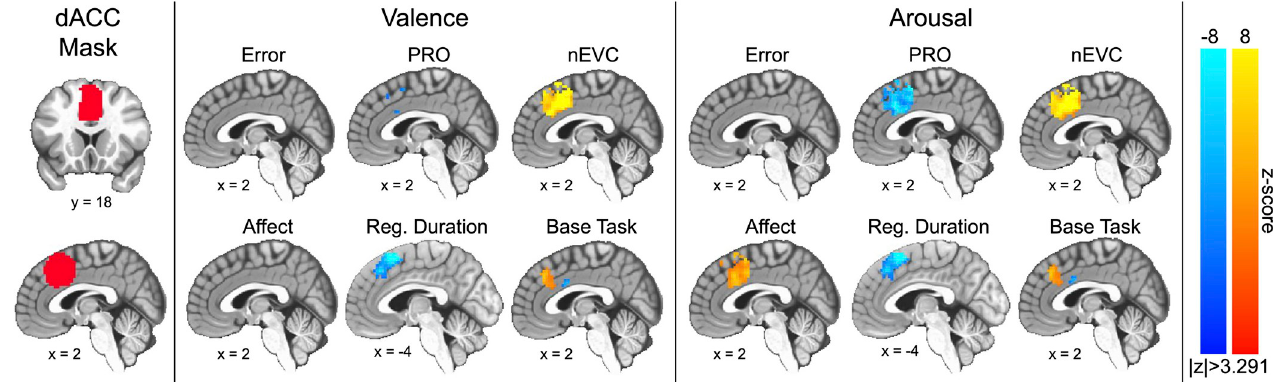
Fig 3. Group-level linear mixed-effect model distributions for the main fixed-effects of error, predicted response outcome (PRO), negated expected value of control (nEVC), affect processing, regulation duration, and base task (i.e., intercept) constrained to a mask of the dorsal anterior cingulate cortex (dACC). The figure depicts slices in MNI coordinate space and neurological convention (image left equals participant left). The figure depicts voxel intensities as colors having a minimum (thresholded) voxel intensity of |z| > 3.291 and a maximum absolute voxel intensity of |z| = 8.0, i.e., color saturates for absolute z-scores above the maximum intensity. To correct for multiple comparisons (p < 0.05), the figure depicts only valence-derived clusters having � 15.3 contiguous voxels (measured as face-wise nearest neighbors, i.e., NN = 1) or arousal-derived clusters having � 15.8 contiguous voxels. Note, the sagittal plane slice representing effects of regulation duration has been shifted to accommodate the entirely left-lateralized effect. Also note that an alternate sagittal slice representation of valence-derived predicted response outcome is presented in S10 Fig, which more fully captures this measure’s negative encoding.